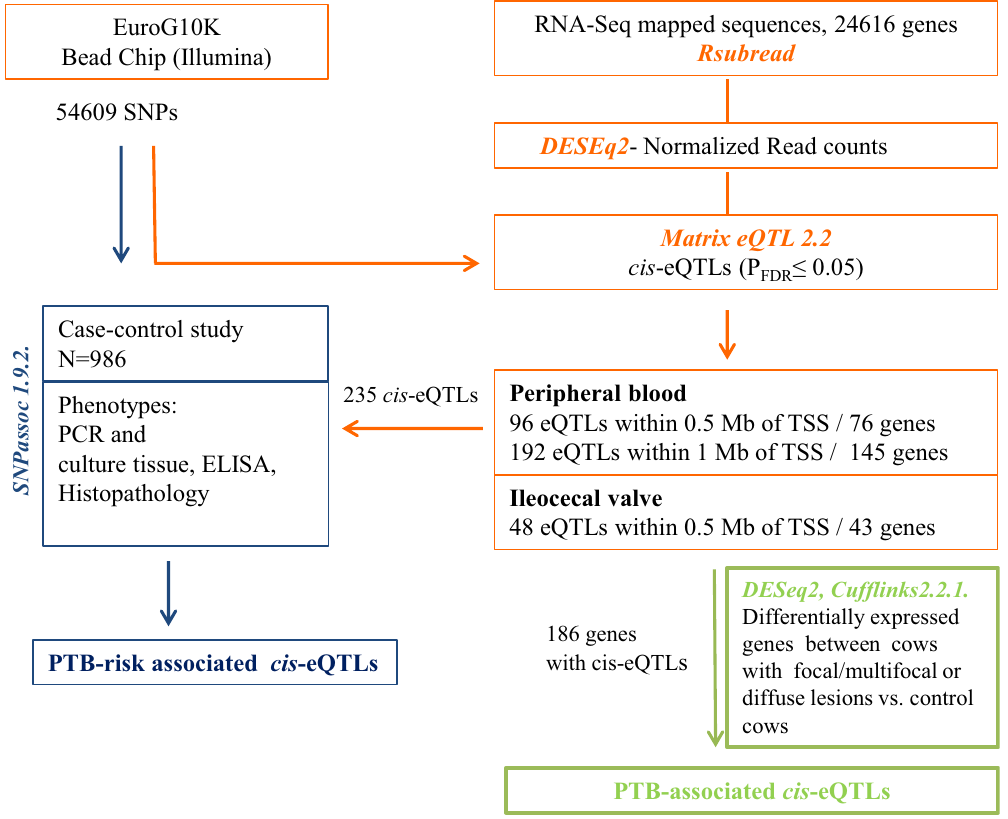
Figure 1. Study design. The approach starts from the individual expression levels, then identifies genetic variants controlling differences in gene expression, and finally checks that the identified cis -eQTLs are indeed associated with disease outcome.